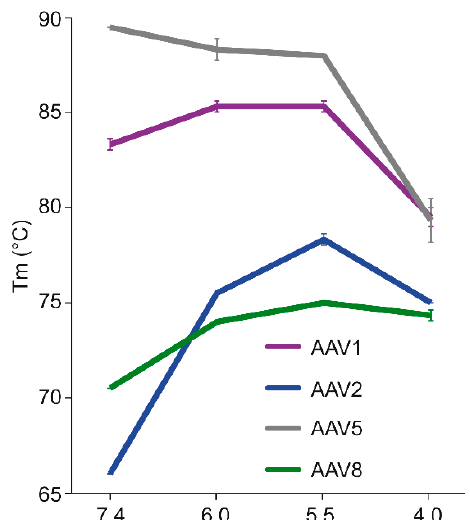
Figure 9. Melting temperature of AAV capsids under different pH conditions. Plot of the T m for AAV1, AAV2, AAV5, and AAV8 at physiologic (7.4), early endosome (6.0), late endosome (5.), and lysosome